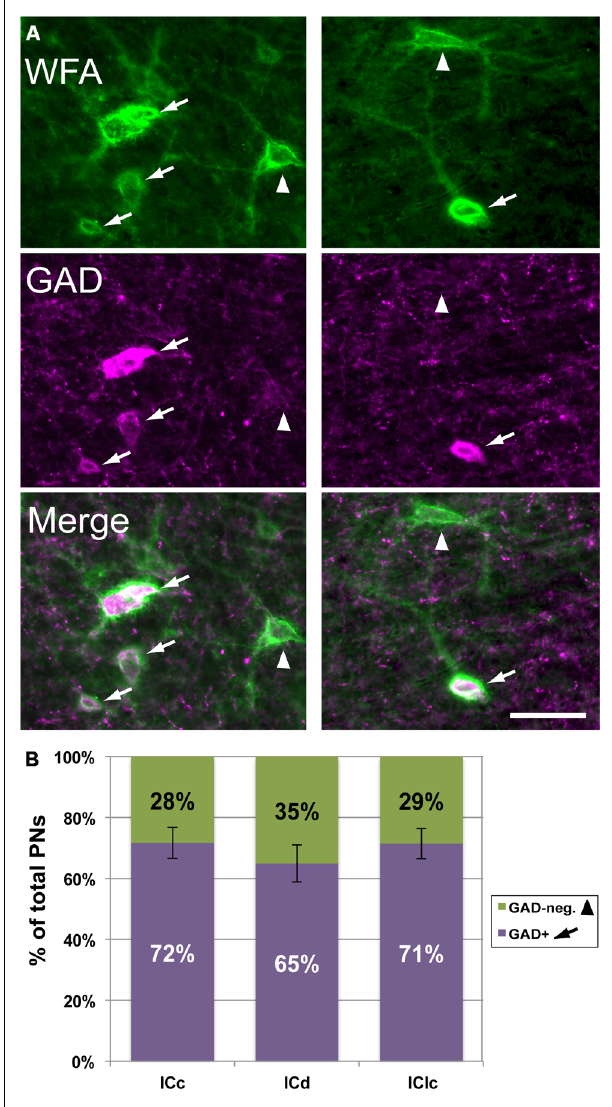
FIGURE 5 |WFA-labeled PNs surround both GAD+ and GAD-negative IC cells. (A) Photomicrographs from IClc (left column) and ICd (right column) showingWFA-labeled PNs (top row) and cells stained with antibodies to GAD (middle row). Bottom row shows the merged images, revealing PNs around GAD + (arrows) and GAD-negative (arrowheads) IC cells. Scale bar = 50 μ m. Case GP691. (B) Graph showing the percentages ofWFA-labeled PNs that surround GAD + (purple bars) vs. PNs that surround GAD-negative (green bars) cells in each IC subdivision.The symbols in the legend correspond to those in (A) . Error bars = SEM; data are averaged across 74 sections in nine animals.